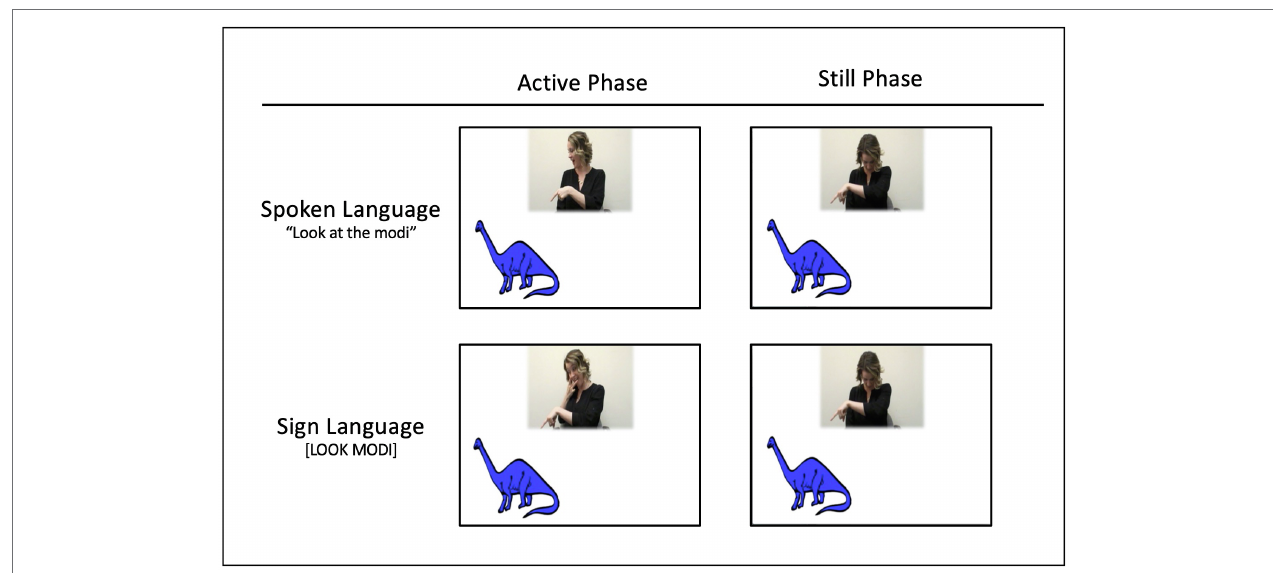
FIGURE 1 | Screenshots depicting one representative trial of the eight trials. In the active phase (left), the woman looks back and forth between the infant and the object while pointing to it and labeling it. This is followed by a still phase (right) in which she ceases all activity, gazing down to break eye-contact. Infants were randomly assigned to condition; in each condition, we counterbalanced (i) whether infants saw a series of images of fish or dinosaurs, and (ii) whether the first image appeared on the right or left side (the image appeared on alternating sides across the eight